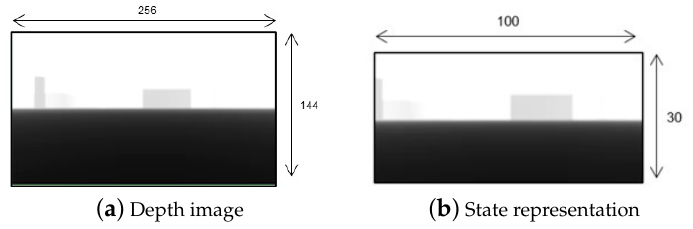
Figure 7. Representation of states in the depth image and pre-processed image.